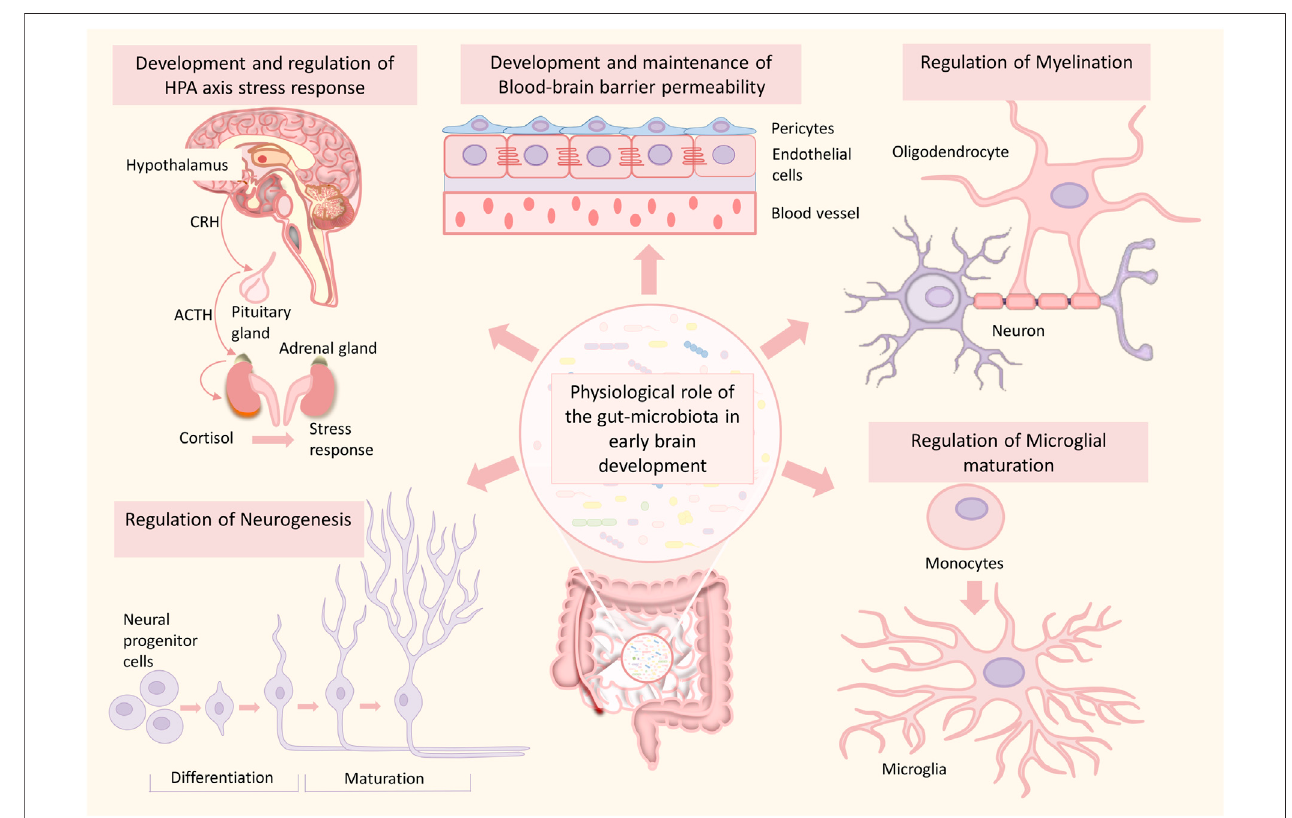
FIGURE2| Roleofthegutmicrobiomeinhealthybraindevelopment.Thegutmicrobiomeplaysanessentialroleinvariousprocessesofbraindevelopmentsuchas neurogenesis, myelination, microglial maturation, development and maintenance of blood-brain barrier integrity, development of HPA-axis, and HPA-axis stress response. Any alterations in this developmental process can signi fi cantly increase the risk for neurodevelopmental disorders.